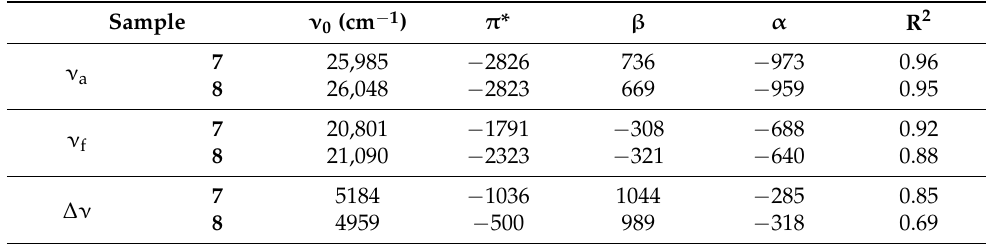
Table 6. Estimated coefficients for multilinear analysis of ( ν a , ν f , ∆ ν ) of 7 and 8 as a function of Kamlet–Taft